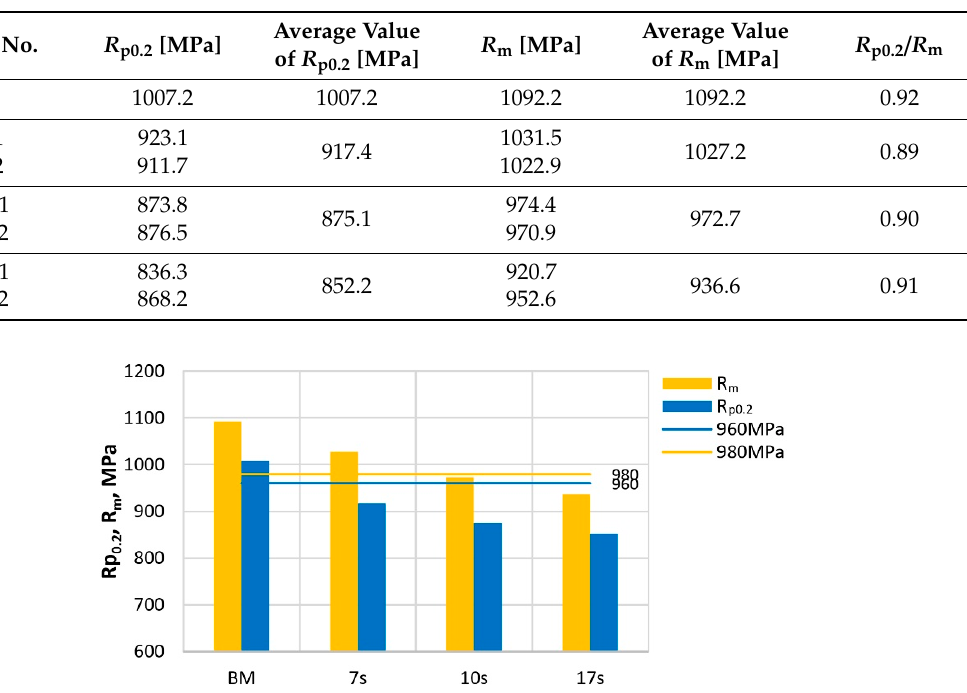
Table 3. Results of the tensile test (at a room temperature of 23 ± 2 ◦ C) for the base material and samples a ff ected by the thermal cycle under di ff erent cooling times t 8 / 5 .